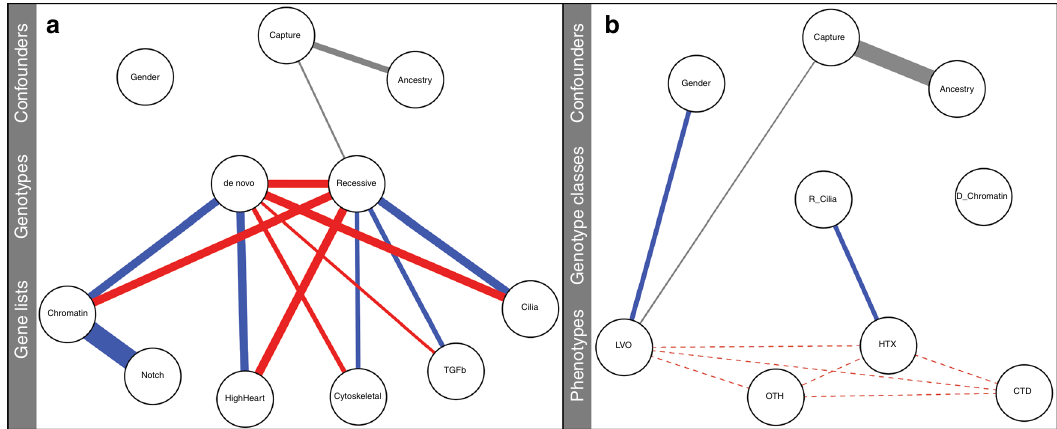
Fig. 6 Genetic and phenotypic landscapes for 2391 patients with congenital heart defects nodes in these two Bayesian networks correspond to genotypes, gene functions, tissue of expression, phenotypes, and potentially confounding variables such as ancestry and gender. Connections, or edges, between nodes denote conditional dependencies. The width of an edge is proportional to the relative strength of the dependency, calculated as the average pairwise fold change in risk. Blue denotes positive dependencies; red denotes negative dependencies. Relationships between multistate nodes (gender, ancestry and capture method) are shown in gray, because the nature of an association (positive or negative) can vary by state, e.g. male or female for gender. Unconnected nodes indicate conditional independence. See text for additional details. a Genotypes and gene functions. Relationships between recessive and de novo damaging genotypes, and gene lists. Cilia: SysCilia and cilia-related genes; HighHeart: genes highly expressed in the embryonic heart; TGF- β ː TGF- β pathway associated genes; Notch: Notch-pathway associated genes; Chromatin: chromatin-modifying and related genes; Cytoskeletal: cytoskeleton- related genes. b Genotype classes and phenotypes. Relationships between proband phenotypes, and recessive and de novo damaging genotypes in cilia and chromatin-related genes, respectively. HTX: heterotaxy; CTD: conotruncal defects; LVO: left ventricular out fl ow defects; OTH: other phenotypes. Dotted lines denote mutually exclusive